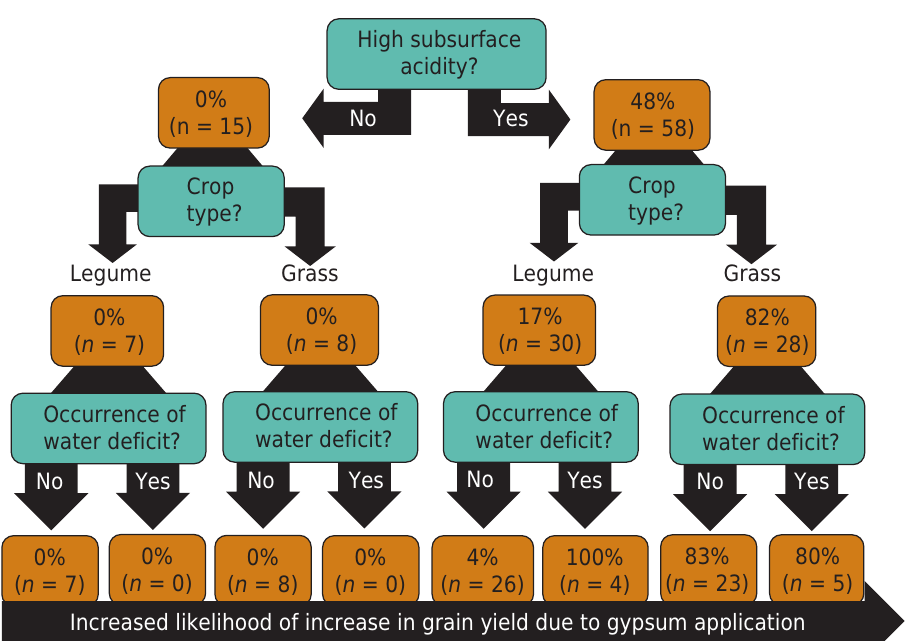
Figure 7. Decision tree to increase grain yield by applying gypsum to subtropical soils under no-tillage in South of Brazil. High subsurface acidity means Al saturation >10 % and/or exchangeable Ca content <3.0 cmol c dm -3